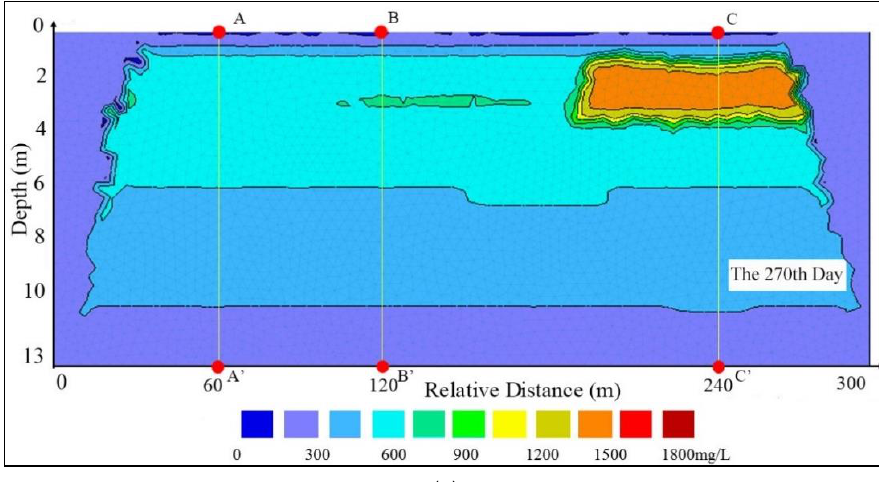
Table 3 Correlation analysis between simulated and monitoring Table 3. Correlation analysis between simulated and monitoring values.